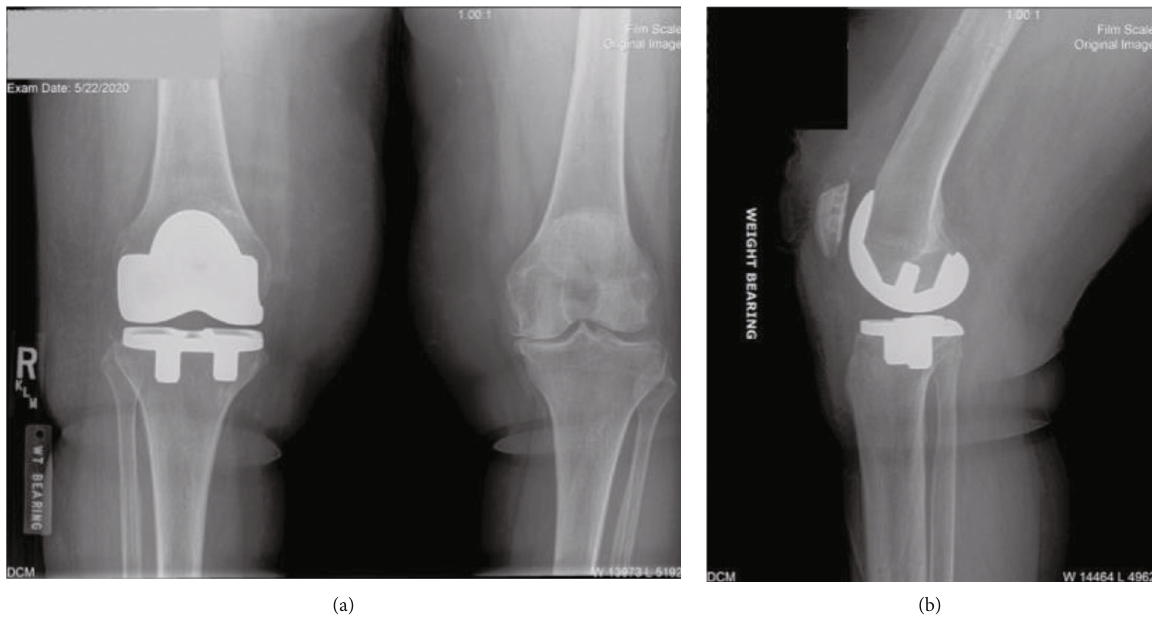
Figure 3: Postoperative AP (a) and lateral (b) X-rays of the right knee for Case 1.